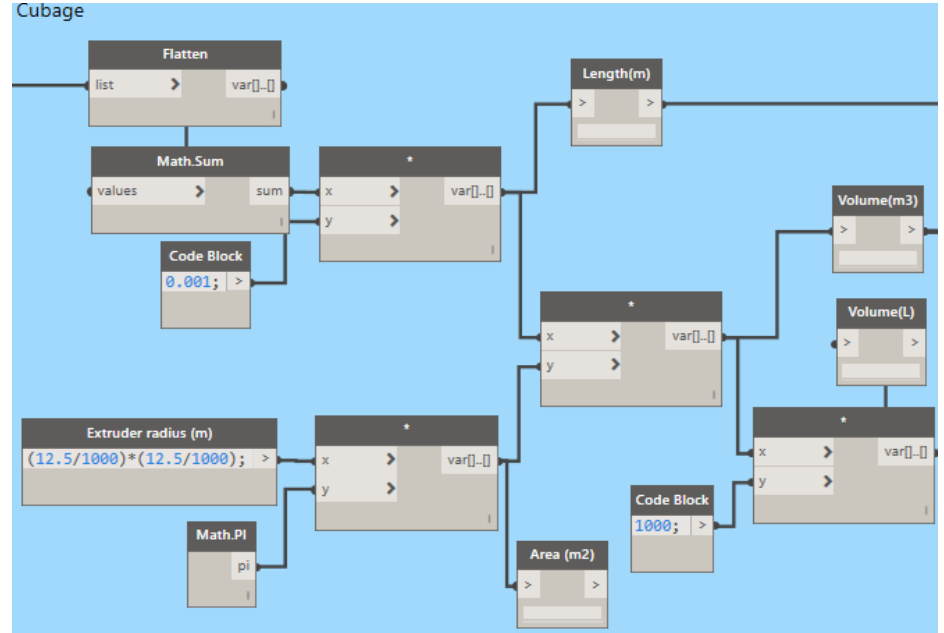
Figure A12. Calculations of the printing material.